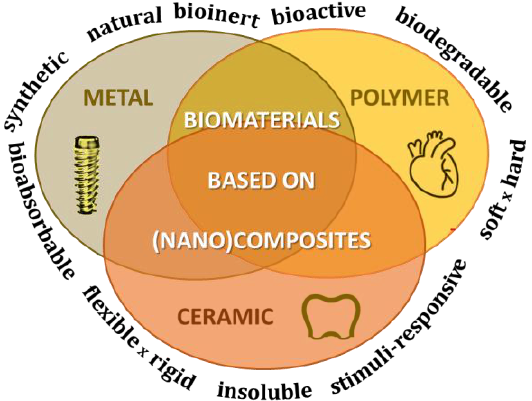
Figure 1. Classification of biomaterials by chemical composition. Materials having two or more phases are nominated (nano)composites. Biomaterials can have several properties guiding a particular application.